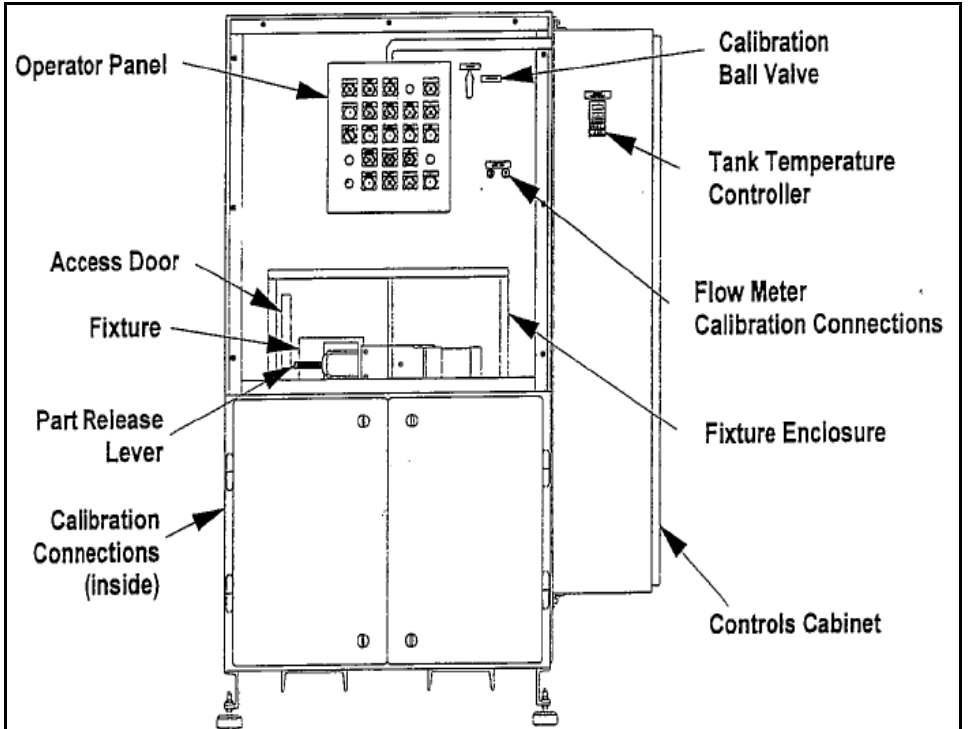
Figure 1: Experimental setup for EFC valve